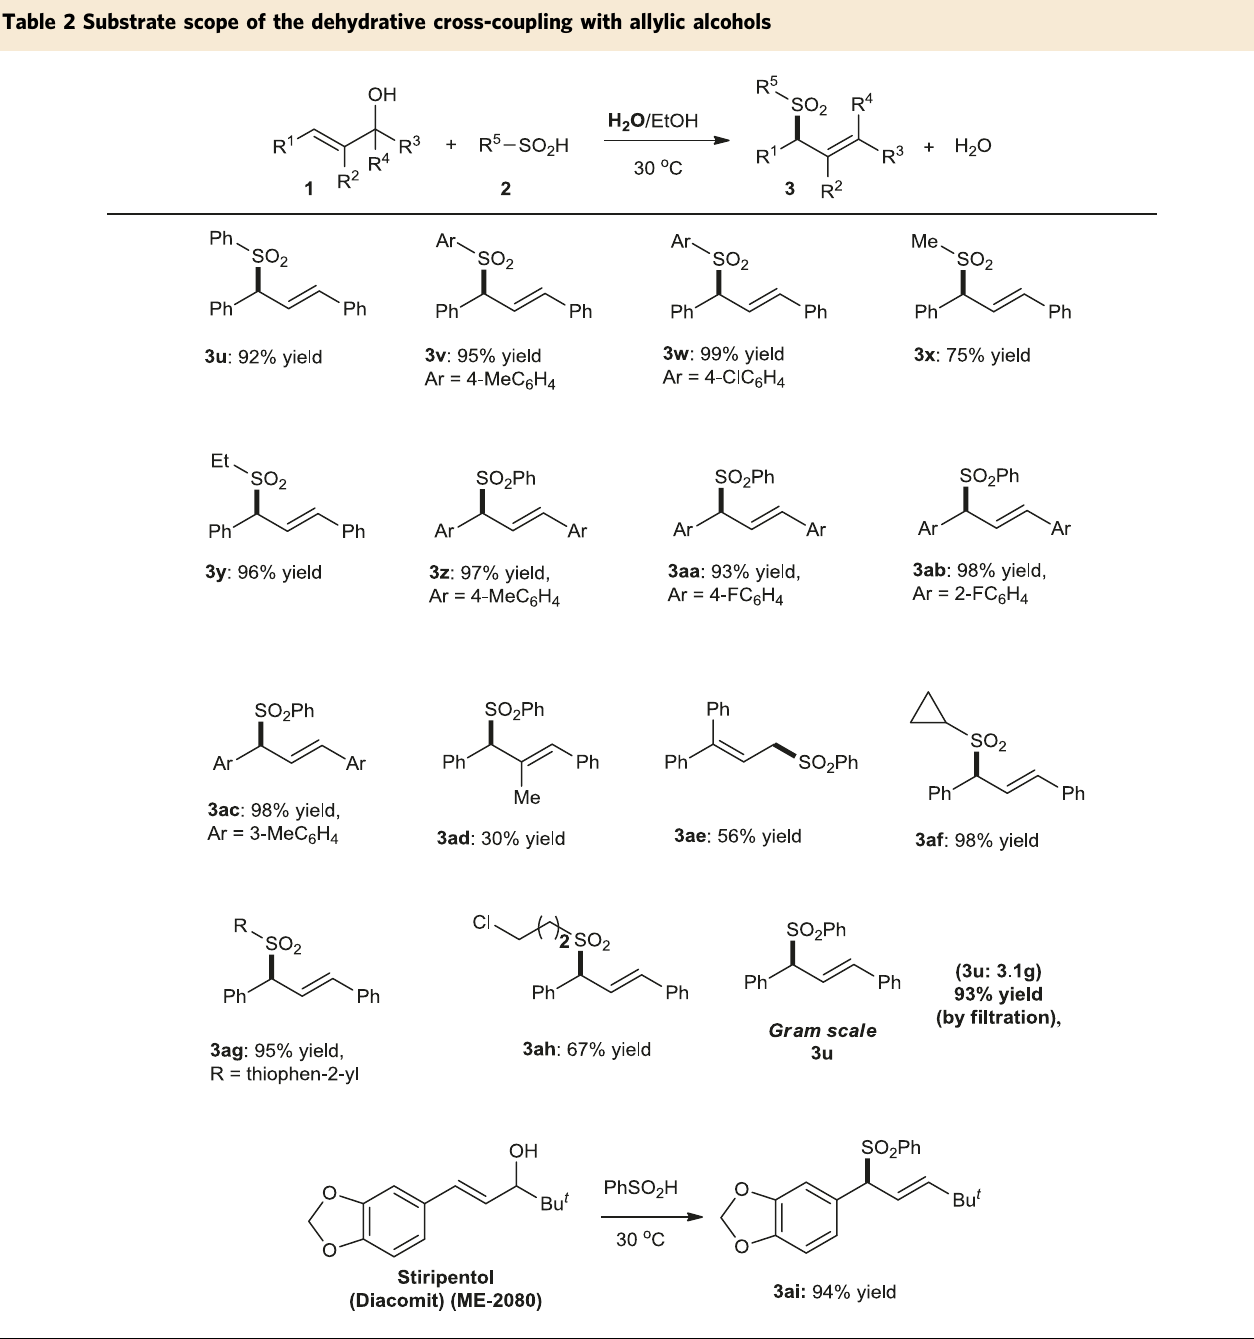
Table 2 Substrate scope of the dehydrative cross-coupling with allylic